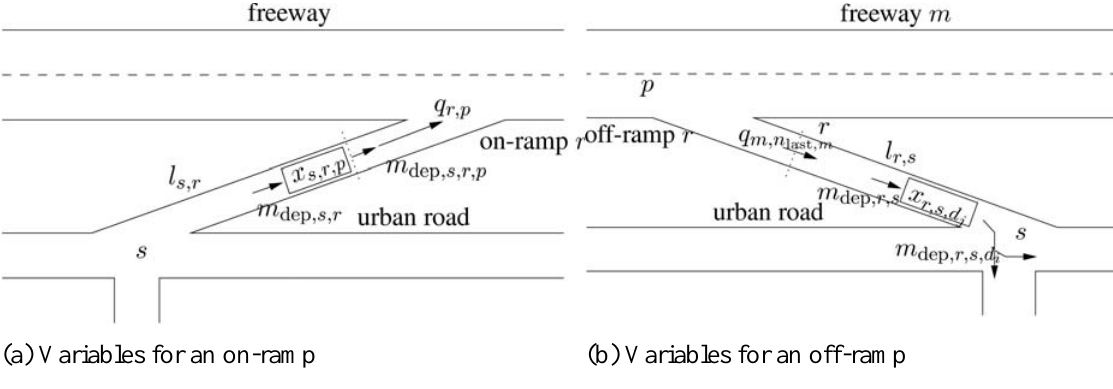
Figure 4. Overview of variables on on-ramps and